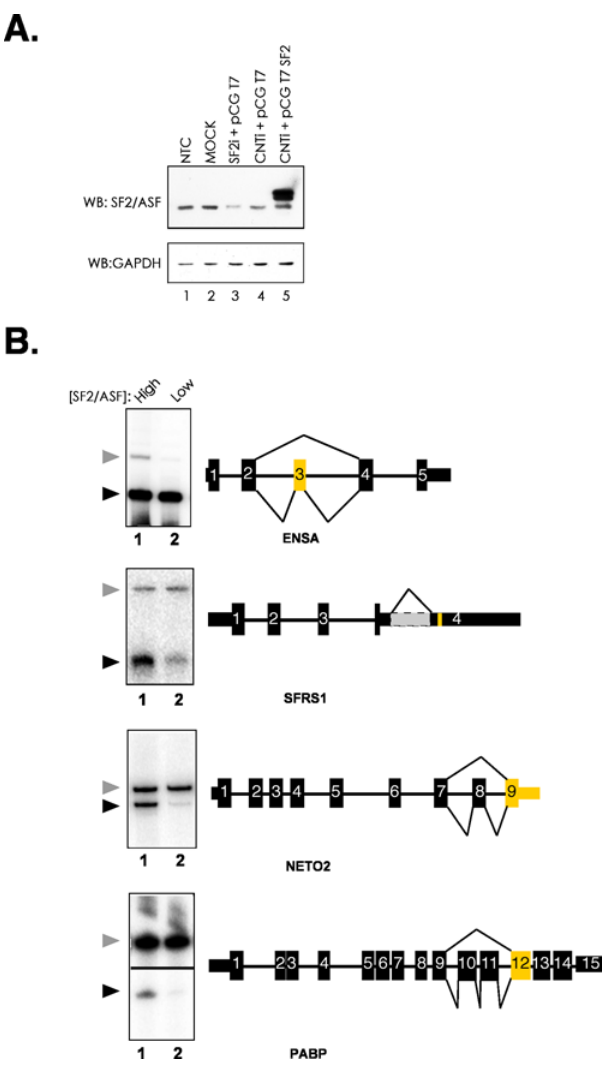
Figure 4. Alternative splicing of endogenous RNA transcripts targeted by SF2/ASF. A) Western blot analysis of HEK293T cells co- transfected with siRNA duplexes and expression plasmids. The upper panel is probed with anti-SF2/ASF monoclonal antibody, the lower panel is probed with anti-GAPDH monoclonal antibody. Lane 1, non transfected control (NTC); Lane 2, Mock (no siRNA or plasmid); Lane 3, siRNA targeting SF2/ASF and empty vector (pCGT7); Lane 4, scrambled siRNA and empty vector; Lane 5, scrambled siRNA and T7-tagged SF2/ASF expression plasmid (pCGT7 SF2). Total RNA was purified for RT-PCR analysis from samples corresponding to lanes 3 and 5. B) RT-PCR analysis of alternative splicing. Radiolabeled products were visualized by phosphorimaging. Schematic diagrams show exon-intron structure of target genes and patterns of alternative splicing. Thin rectangles indicate untranslated regions, thick rectangles indicate coding regions, thick lines indicate introns and thin lines indicate the alternative splicing event. Exons identified by CLIP are yellow. The grey region in the SFRS1 3 9 UTR indicates a retained intron. Arrowheads to the left of each panel indicate the included (gray arrowhead) and skipped (black arrowhead) alternative mRNA isoform. Lane 1 and 2 contain RNA purified from SF2/ASF overexpressing and depleted cells, for example see panel A, lanes 5 and 3, respectively. The sub-cellular fraction corresponding to the initial CLIP experiment is indicated below each gene